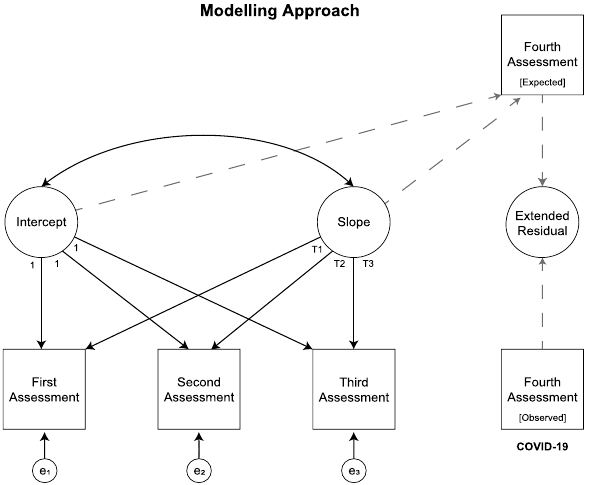
Figure 2. Illustration of latent growth curve modelling and computation of extended residuals; these have been computed for both primary outcome measures separately. Please note we used the exact time point of each assessment as latent slope loadings to account for the length of individual trajectories (cf. Fig. 1 for assessment